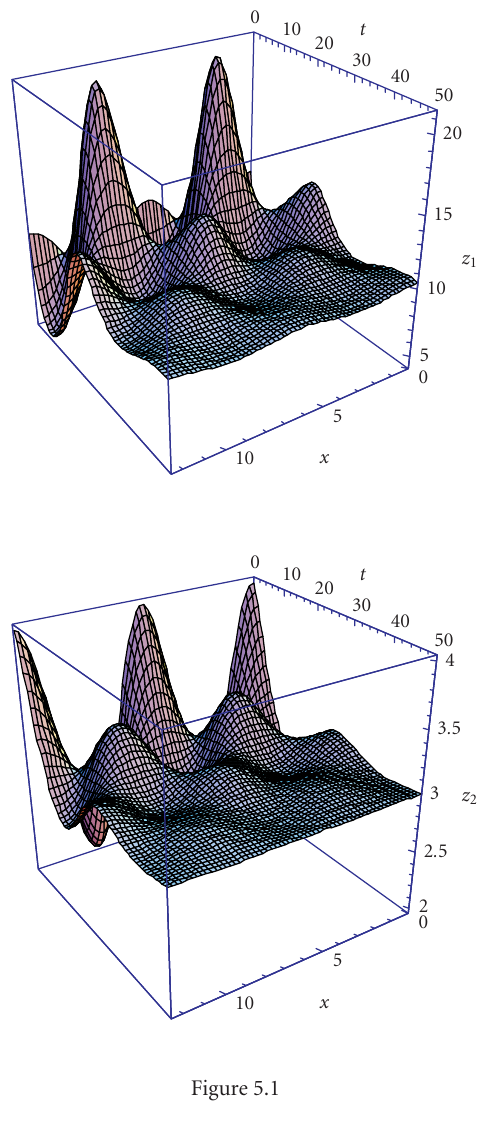
Figure 5.1 illustrates the road to stable equilibrium. A particular cross section ( t = 15) is compared to the initial data (Figures 5.2 and